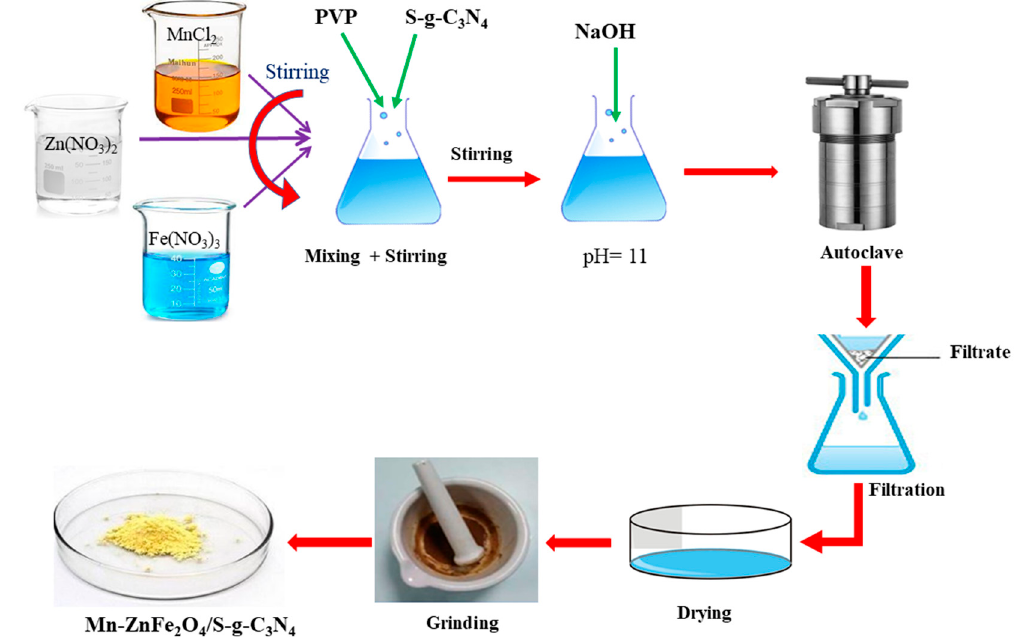
Table 1. Composition of the synthesized Mn-ZnFe 2 O 4 / S-g-C 3 N 4 composites.